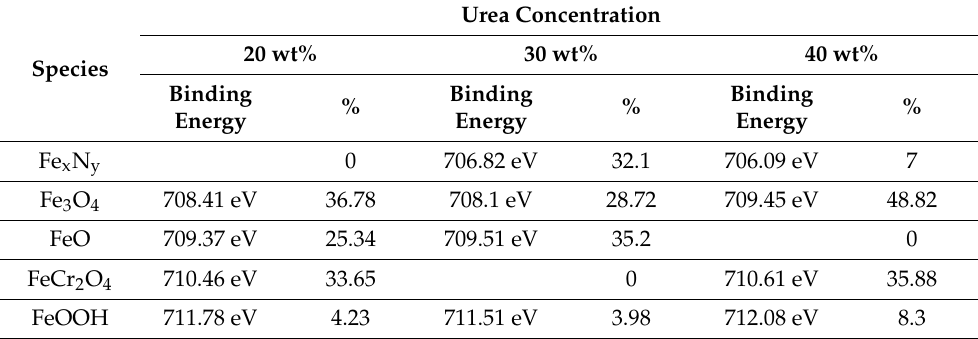
Table 2. Molecular percentages of iron species present on AISI 304 SS surfaces treated with each urea